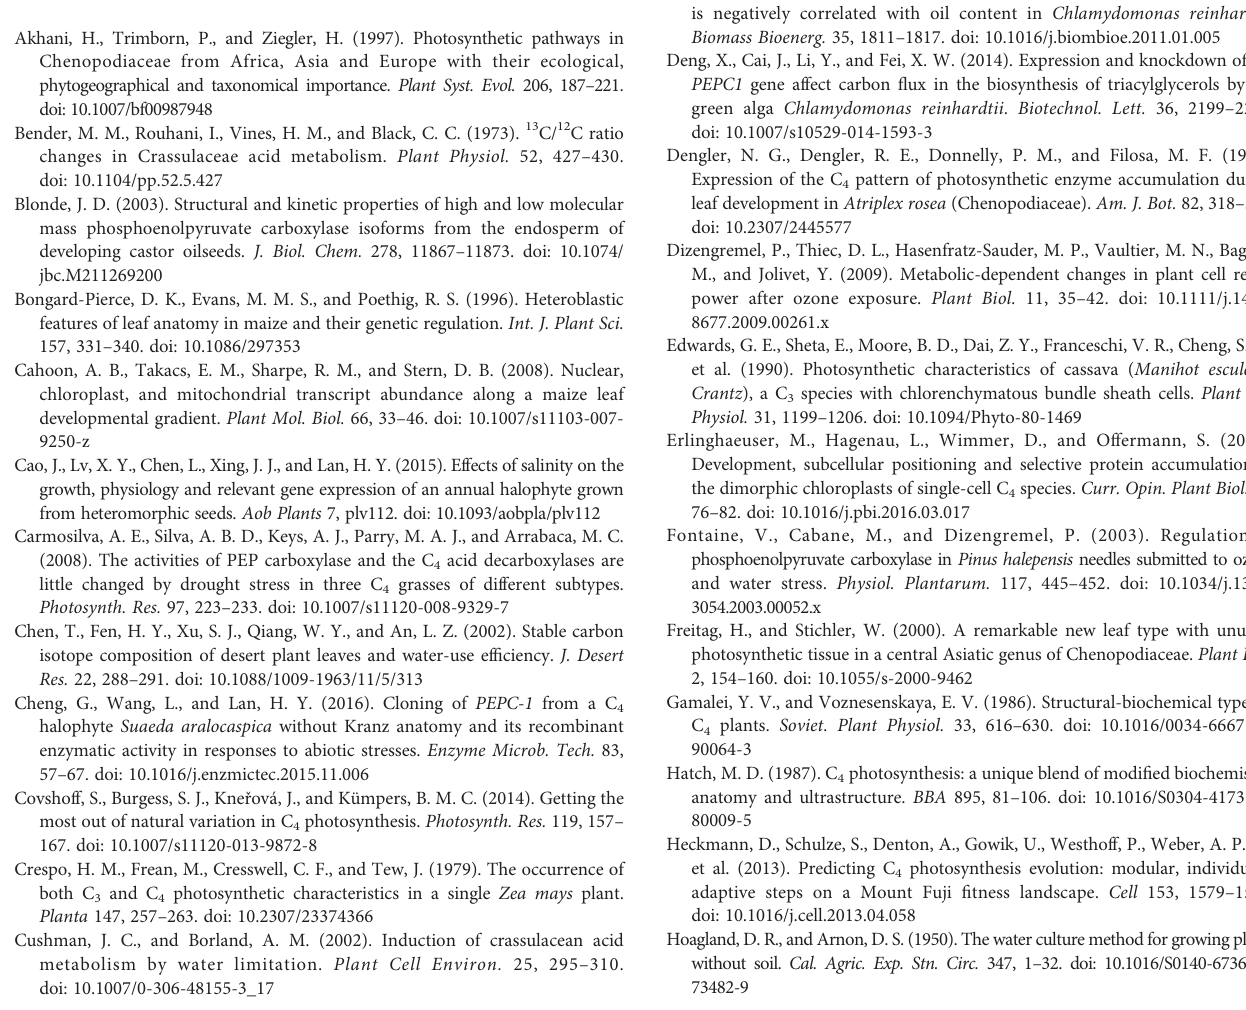
SUPPLEMENTARY FIGURE 1 | Schematic diagram of location and position of cotyledon and true leaf of S. ferganica and S. aralocaspica. (A) S. ferganica ; (B) S.